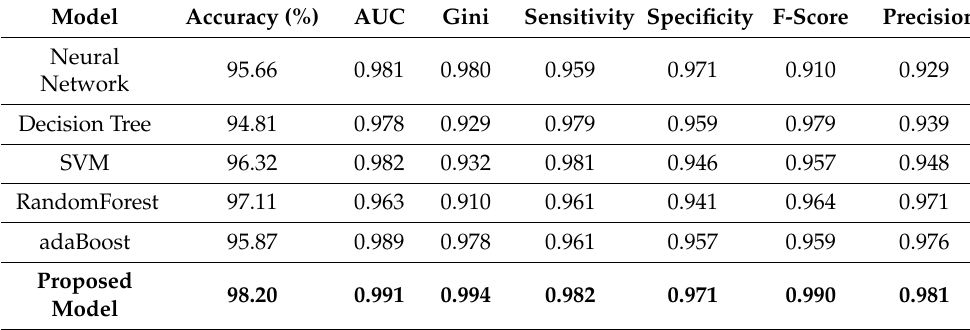
Table 6. Results of proposed and existing prediction models on test dataset.